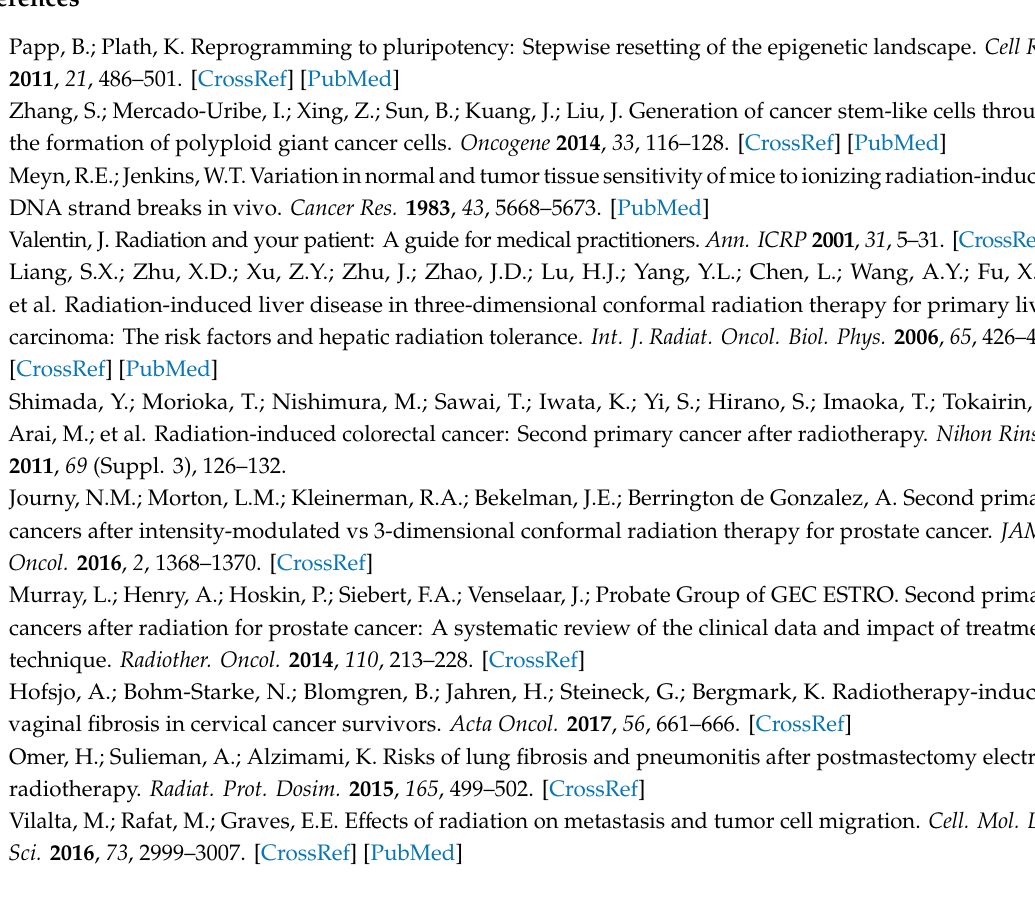
Figure S1: Expression level of apoptosis, fibrosis and cell proliferation-related genes in adult wild-type zebrafish without or with radiation, Figure S2: Expression levels of lipogenic factor and lipogenesis enzyme genes in adult transgenic zebrafish without or with radiation, Figure S3: The expression of hnf4a , ddah1 , 11b-hsd1, asgpr1 , and hnf4a downstream target genes: tdo2a , in zebrafish after irradiation, Table S1: Primer